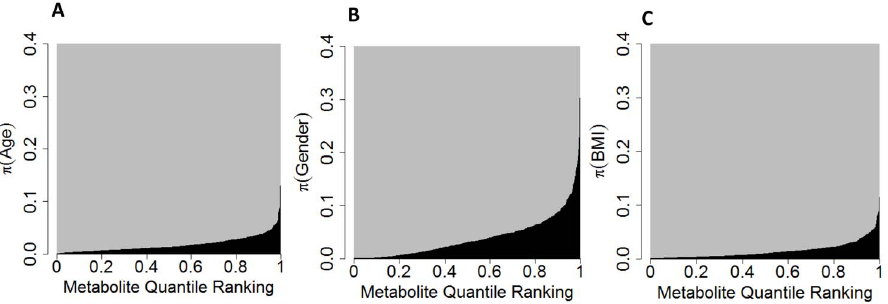
Figure 3. The distribution of ^ pp ( age ) (A), ^ pp ( gender ) (B), and ^ pp ( BMI ) (C). The x-axis represents the metabolite quantile ranking, and the y-axis represents ^ pp . The black areas under the curve illustrate the for the specified metabolite quantile ranking, which shows the variance explained by these three covariates.